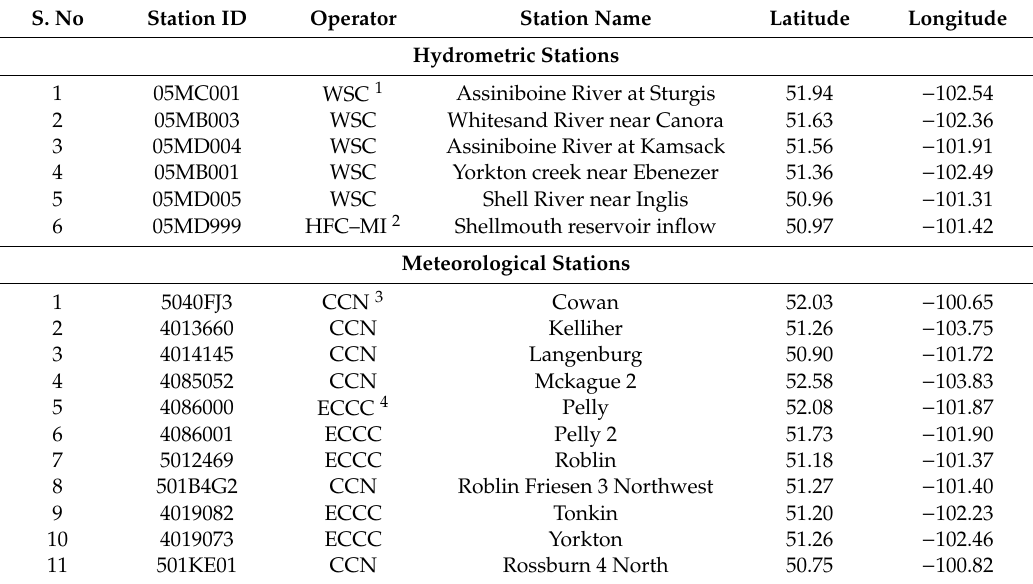
Table 2. Hydro-meteorological stations utilized to construct Shellmouth reservoir SWAT